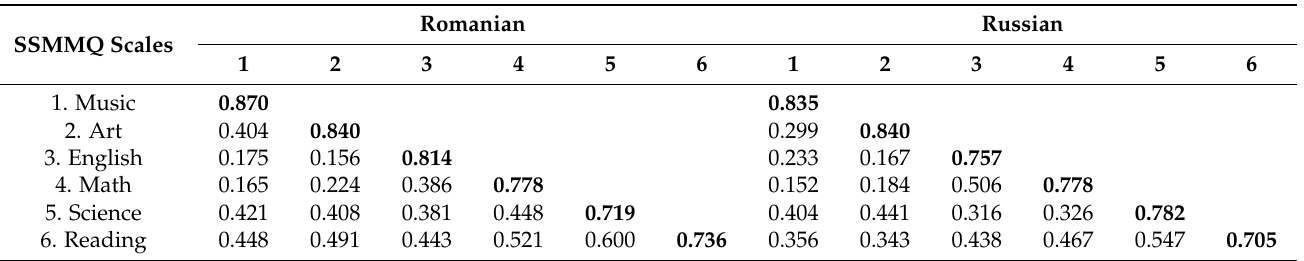
Table 5. Fornell–Larcker criterion: Correlations between the square roots of the AVE of each variable.